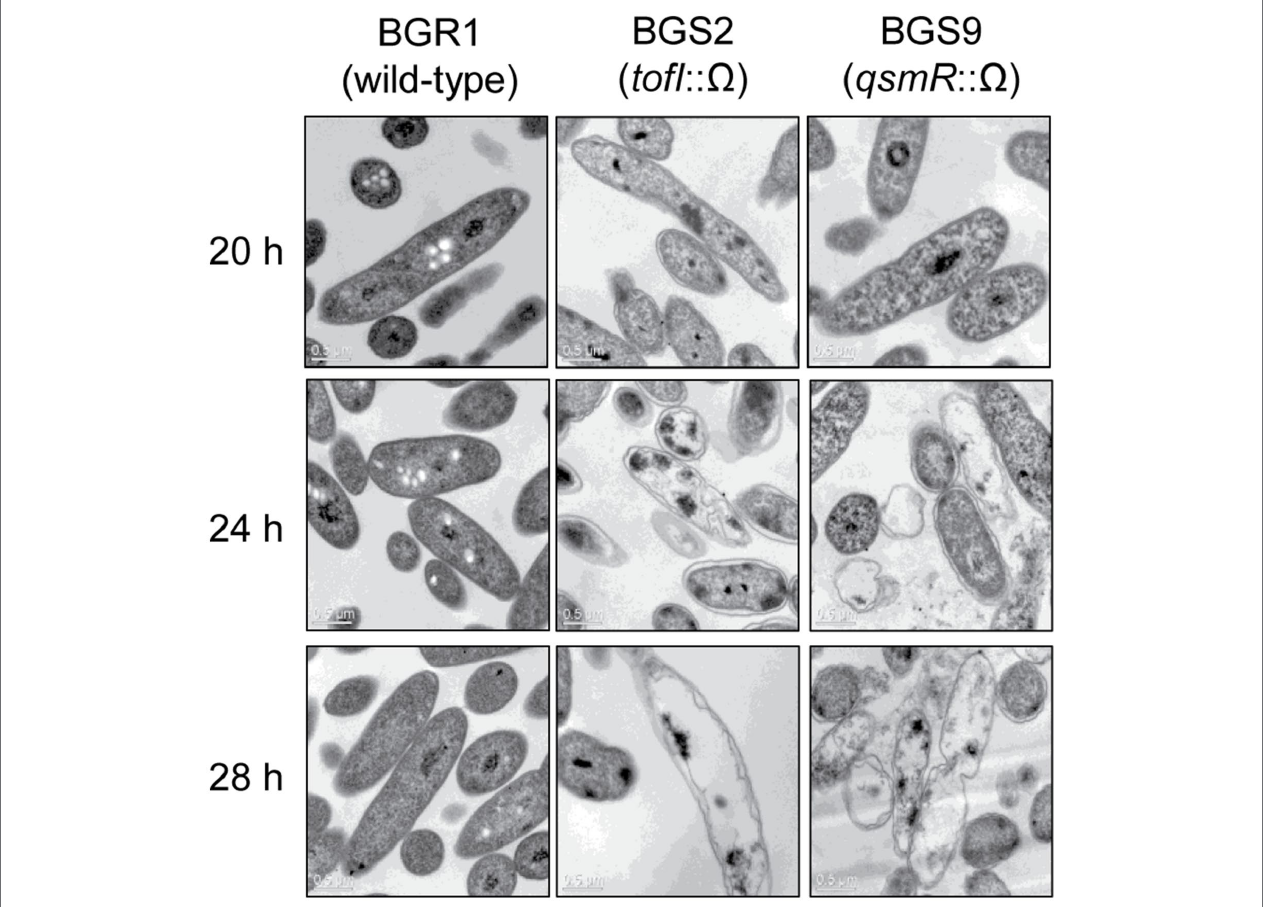
FIGURE 1 | Transmission electron microscopy (TEM) images of wild-type BGR1 and the quorum sensing (QS) mutants BGS2 (BGR1 tofI :: Ω ) and BGS9 (BGR1 qsmR :: Ω ). Wild-type BGR1 and the QS mutants were grown at 37 ° C in Luria–Bertani (LB) broth with shaking. Scale bars, 0.5 μ